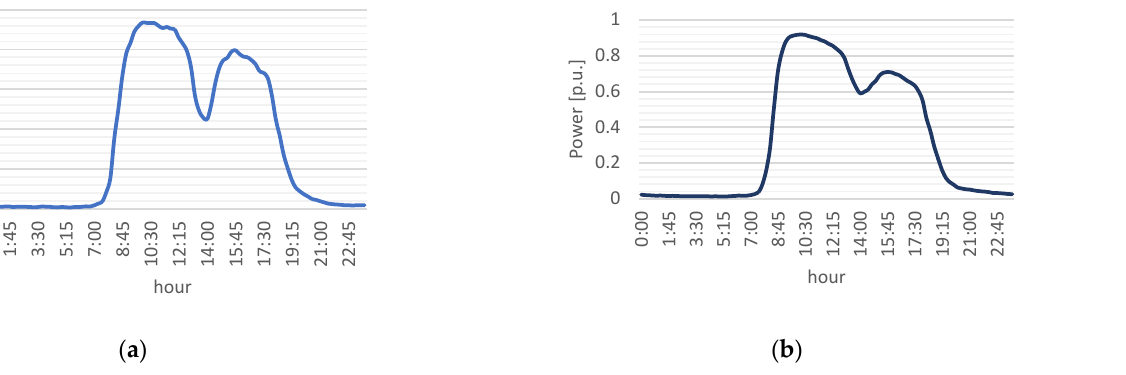
power greater than 10 kW, business day of summer. ( a ) Group 1, ( b ) Group 2, and ( c ) Group 3.